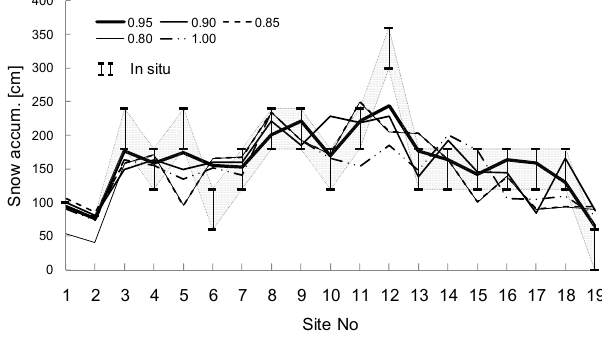
Figure 9. Comparison between the estimated snow depth and the in situ snow depth for various emissivity values (0.80, 085, 0.90, 0.95, and 1.00) at the 19 sites to assess the reliability of the optimum emissivity value of 0.95 for the Greenland ice sheet.